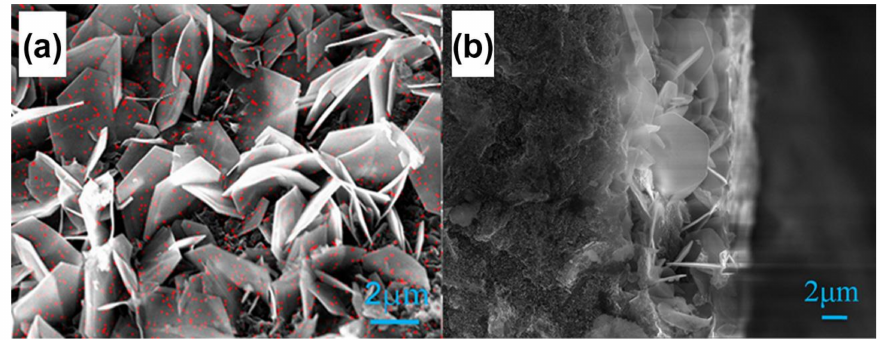
Figure 13. SEM images of the of the bimetallic Pd/Ga catalyst precursor from the surface ( a ) and in the cross section ( b ) (reproduced with permission from [269]. Copyright 2014, Elsevier